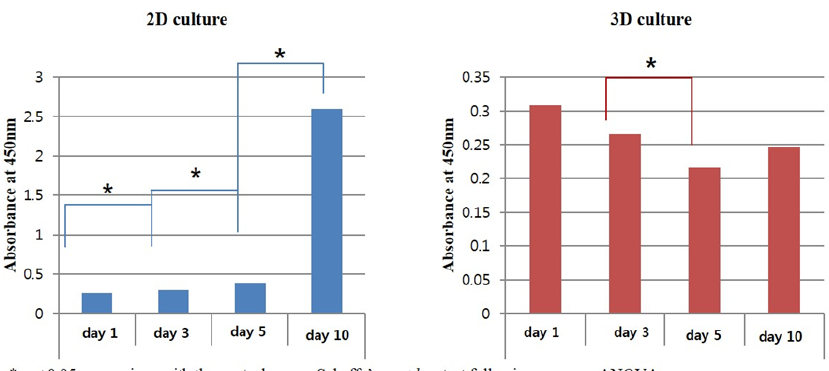
Figure 3. Results of CCK-8 assays. The 2D-cultured sPDLSCs showed an increase in absorbance and 3D-cultured sPDLSCs showed a significant decrease in absorbance from day 1 to day 5. The absorbance of 3D-cultured sPDLSCs increased non-significantly on day 10. * p < 0.05; Scheffé post hoc test following one-way ANOVA.